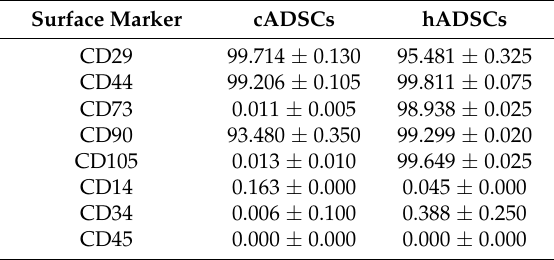
Figure 2. Characterization of cell surface markers in cADSCs and hADSCs by flow cytometry. ( A ) cADSCs are positive to CD29, CD44, and CD90, and negative to CD73 and CD90. ( B ) hADSCs show positivity to CD29, CD44, CD73, CD90, and CD105. Both cell populations are negative to CD14, CD34, and CD45. Table 1. Surface marker expression of cADSCs and